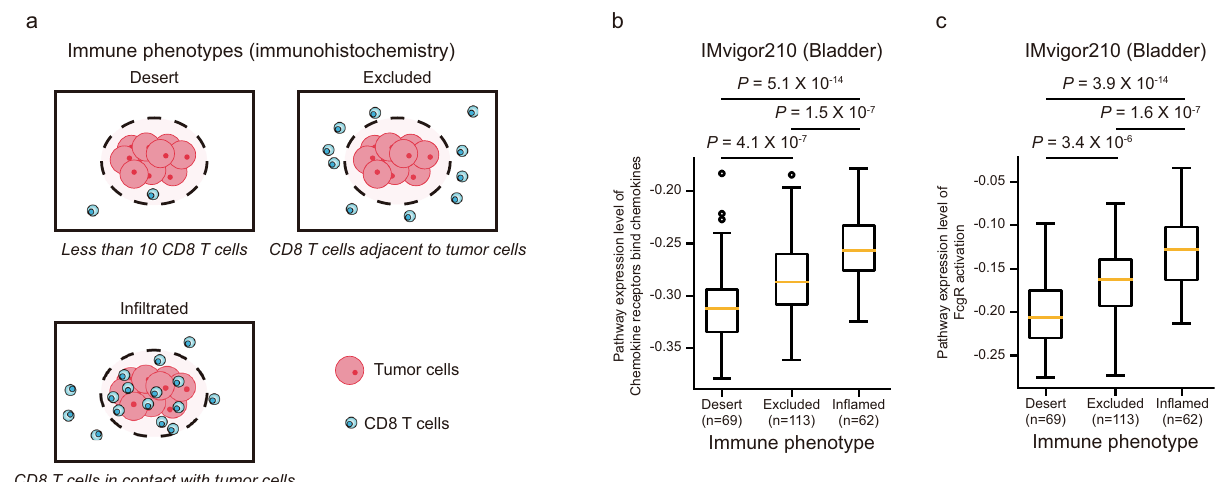
Fig. 6 The expression levels of NetBio pathways are consistent with immunohistochemistry-based immune phenotypes in bladder cancer. a Categorization of immune phenotypes using immunohistochemistry. b , c Expression levels of NetBio pathways in various immune phenotypes. For NetBio pathways, chemokine receptors bind chemokines ( b ) and FcgR activation ( c ) are shown. The two-sided Mann – Whitney U test was used to compute statistical signi fi cance for differential pathway expression levels across different immune phenotype patient groups. Boxplot shows median value, interquartile range (IQR) as bounds of the box and whiskers that extends from the box to upper/lower quartile ± IQR × 1.5. Source data are provided as a Source Data fi